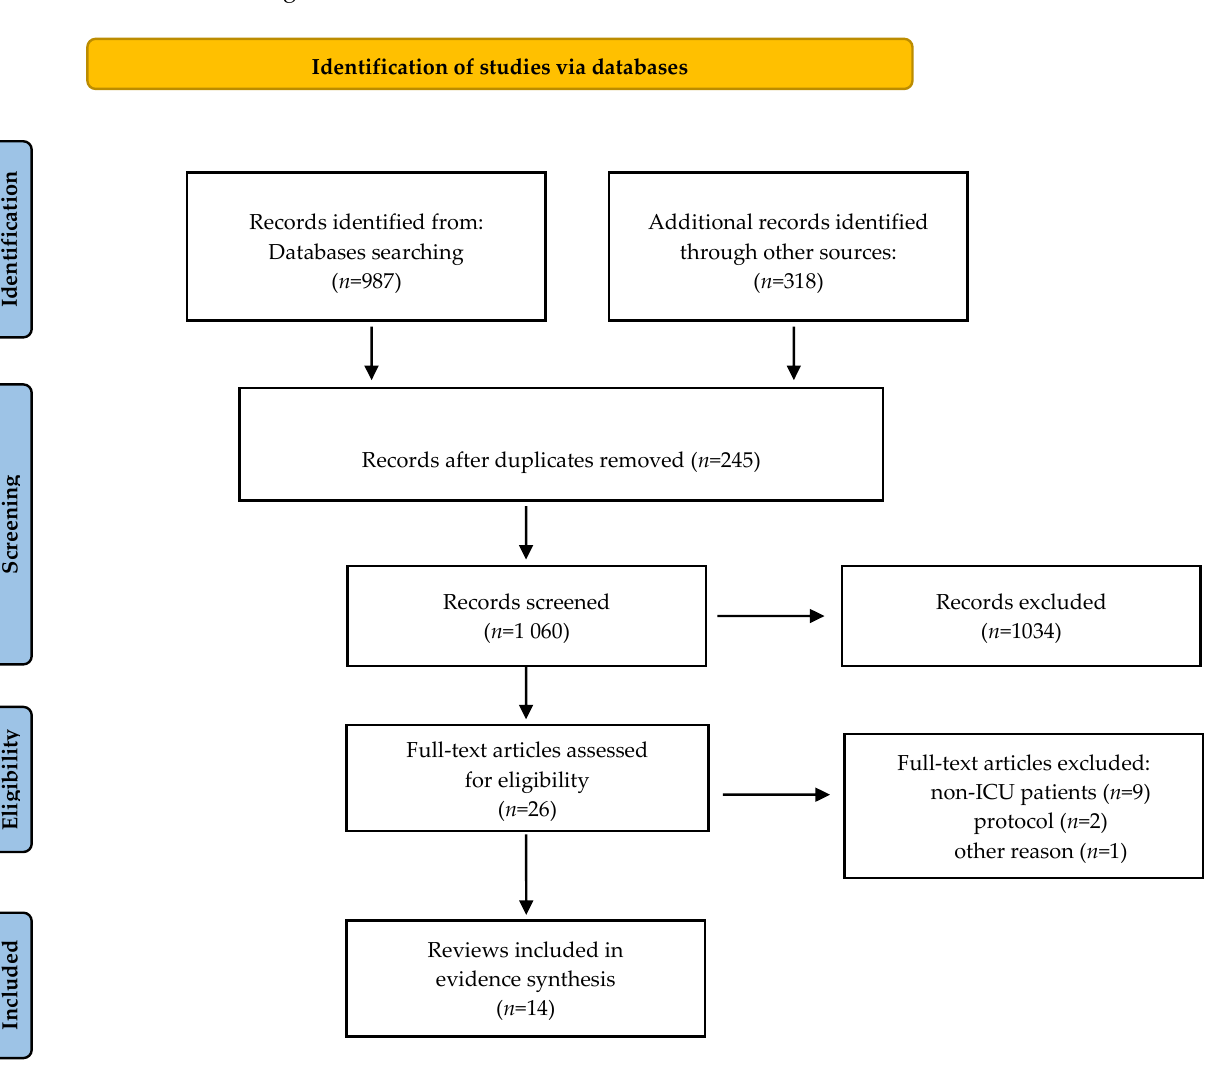
Figure 1. PRISMA flow diagram [38].